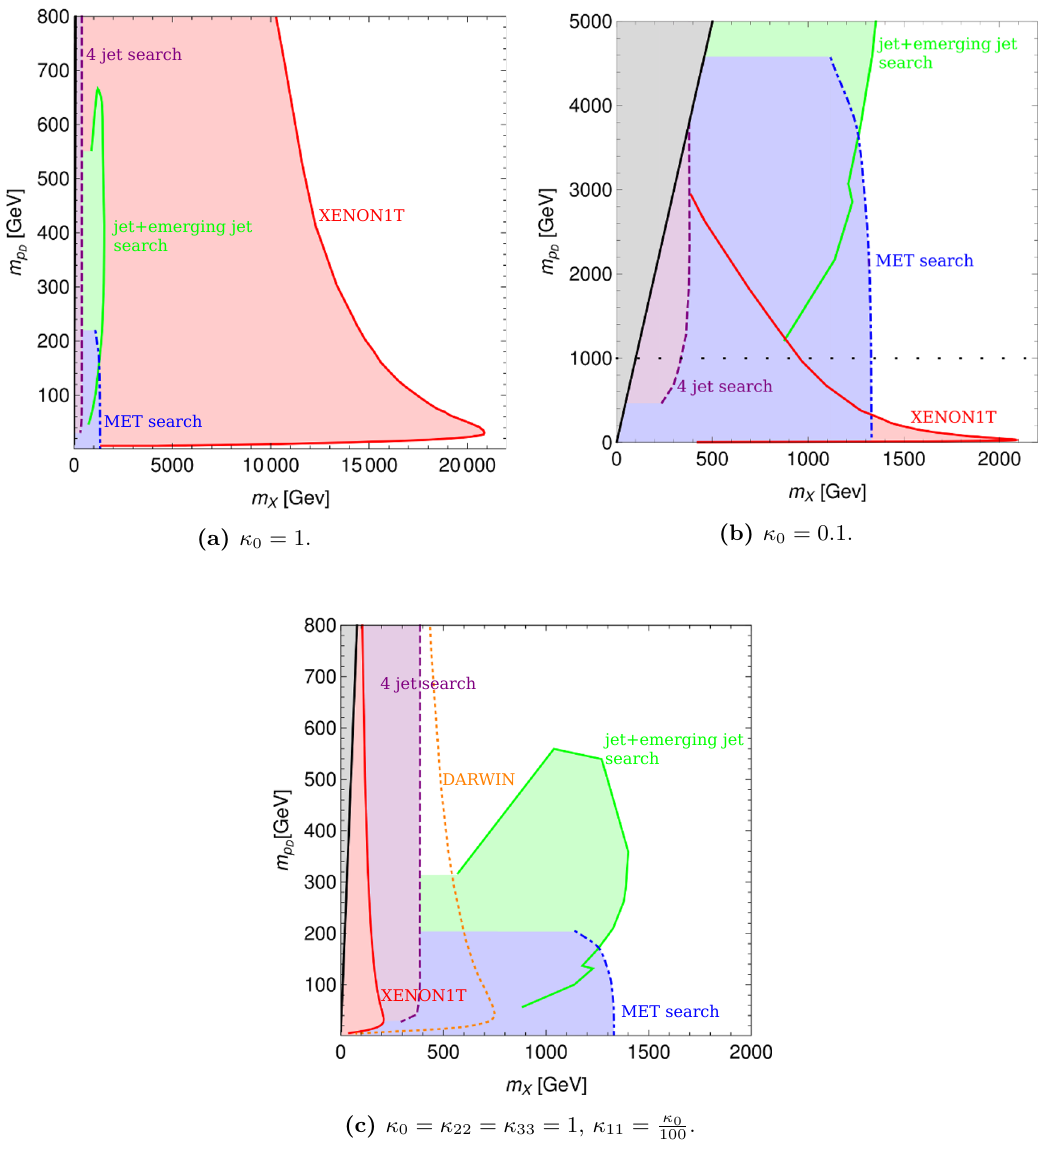
plane for m p = 10 m π . The solid green, D D D